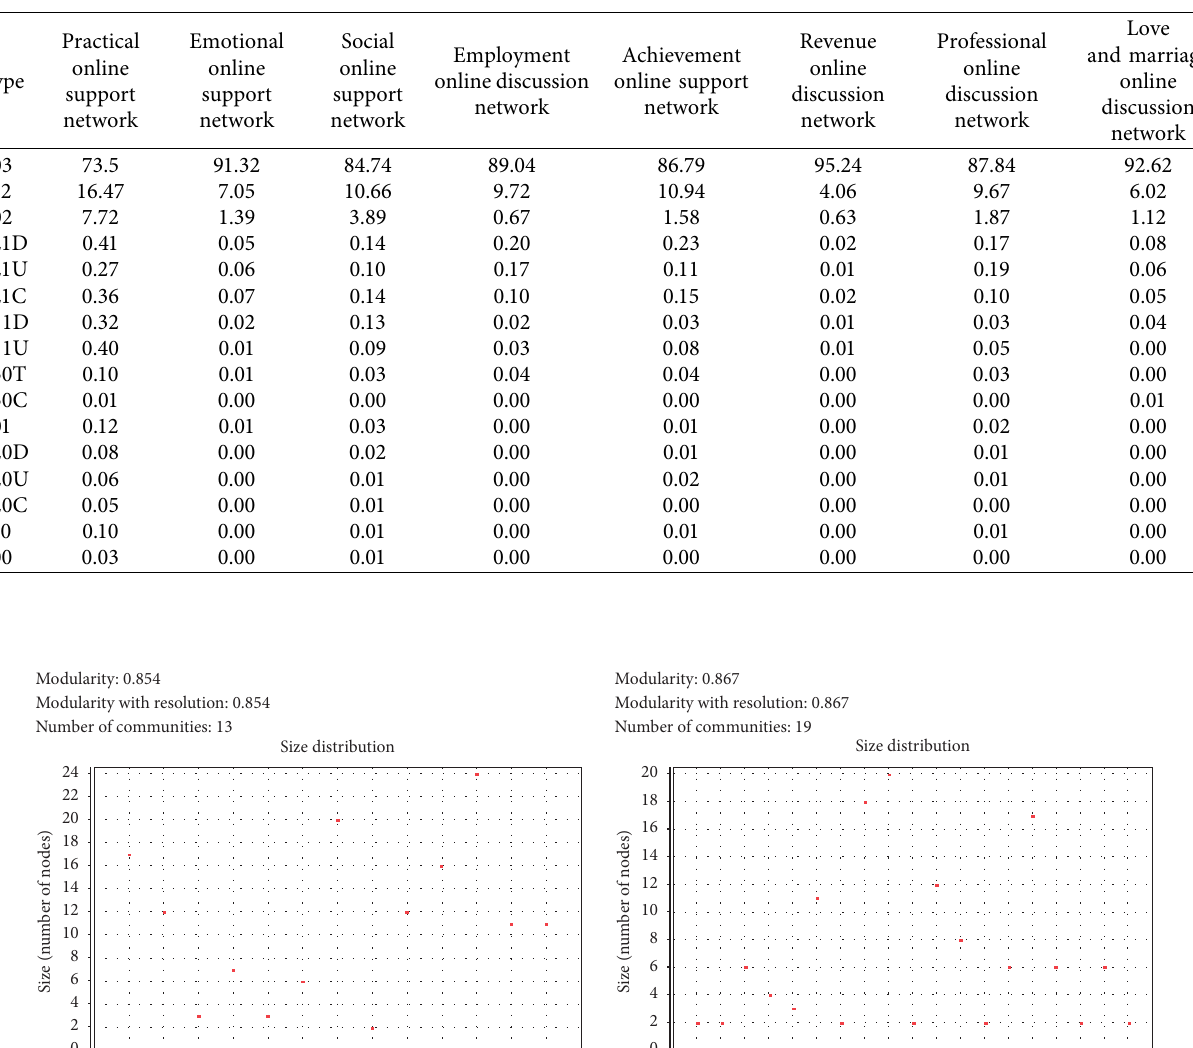
Table 6: Distribution of tripartite relationship.